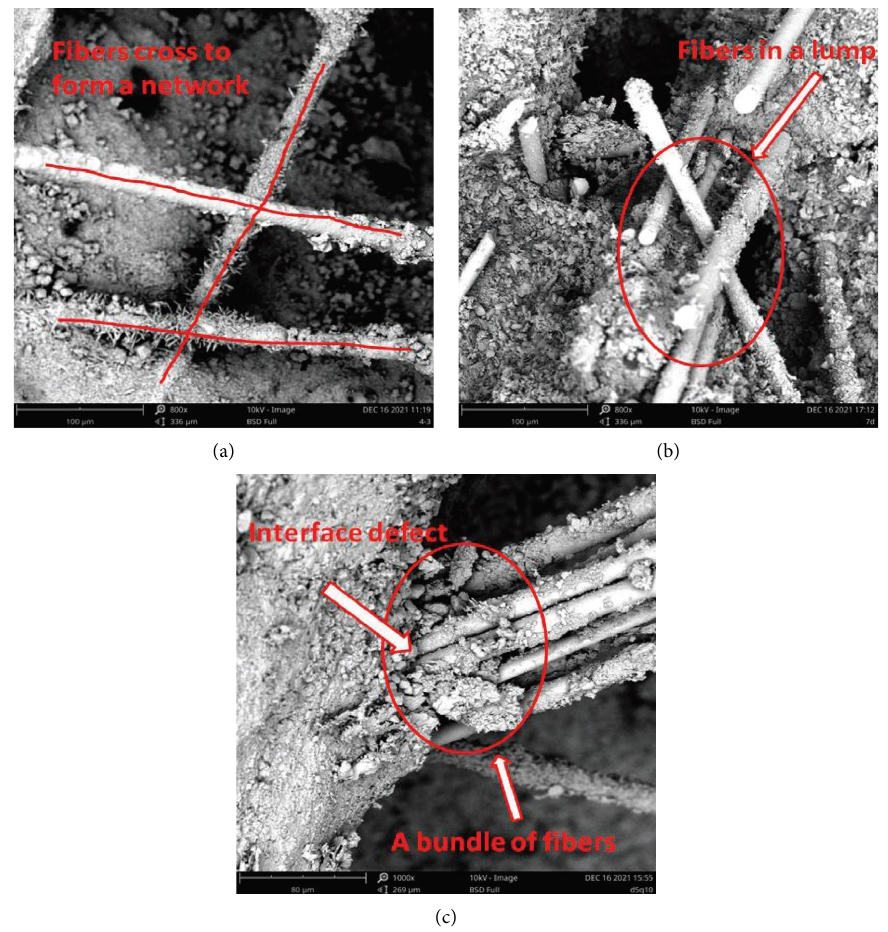
Figure 16: Microstructure of fber-cement-based interface with diferent dosages. (a) Microcosmic diagram of fber-cement base interface with 2kg/m 3 dosage. (b) Microcosmic diagram of fber-cement base interface with 4kg/m 3 dosage. (c) Microcosmic diagram of fber-cement base interface with 6kg/m 3 dosage.